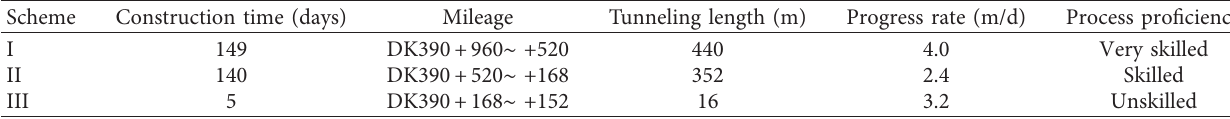
Table 3: Construction progress comparison table.